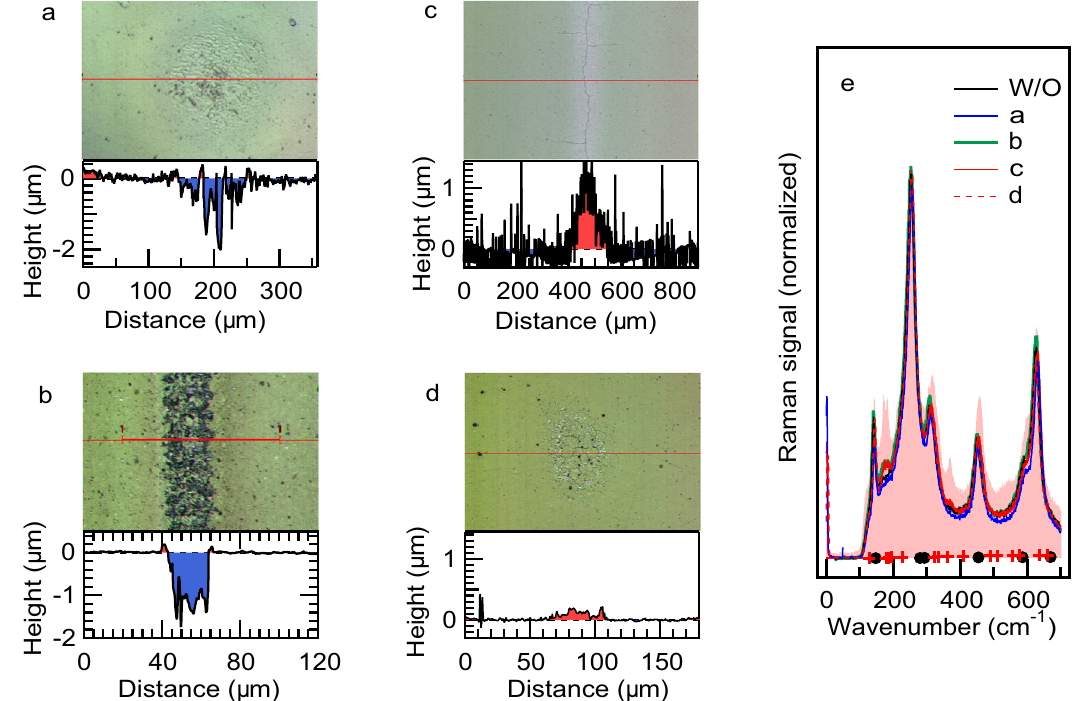
Fig. 5 Characterization of the irradiation scars generated by four different lasers. The photographs of scars generated by UV ( a ) 4 mJ (28 J cm − 2 ), near- IR-femtosecond ( b ) 0.2 mJ (0.2 J cm – 2 ), mid-IR ( c ) 0.6 mJ (3 J cm – 2 ) and 10.2-THz-FEL ( d ) 0.2 mJ (8 J cm – 2 ) irradiation, respectively. The data below the photographs show the height pro fi les of the irradiation scars at the positions indicated by the red line. Red and blue hatches represent rise and depressions in the irradiation spot, respectively. e Raman spectra at the center positions of the irradiation scars generated by UV, near-IR-femtosecond, mid-IR and 10.2-THz-FEL pulses. The red shaded region shows the Raman spectra at the center position of the irradiation scar generated by the 4.2-THz FEL pulse with a pulse energy of 7.5 mJ (12 J cm – 2 ) (Fig. 3). The reference Raman spectrum without the irradiation (W/O) is shown by the black curve. Black dots and red crosses indicate the wavenumbers of the Raman-active modes of t- and m-ZrO 2 28